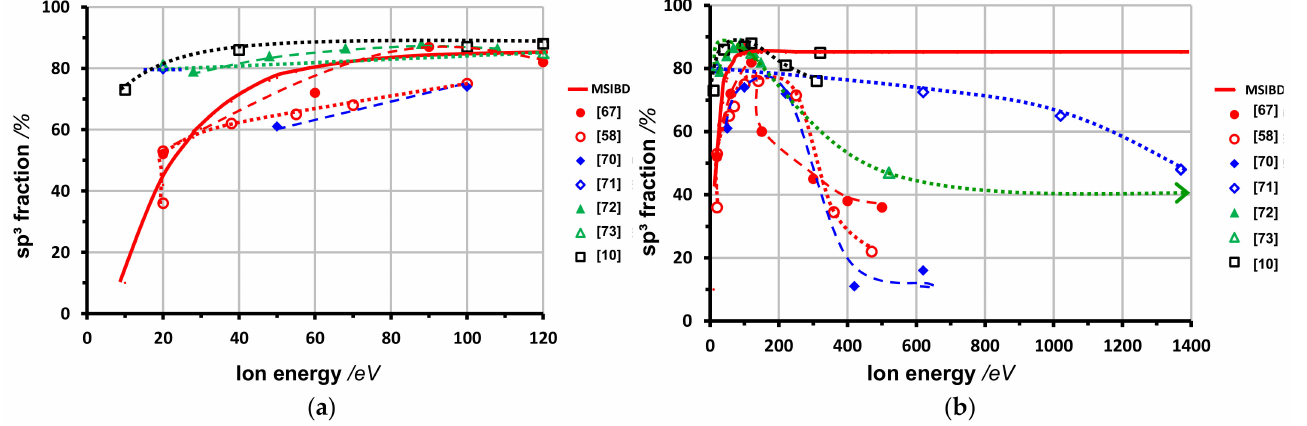
Figure 10. Dependence of the sp 3 fraction (from EELS) on the ion energy for carbon films, deposited by filtered vacuum arc. dc arc: [10,58,67,70–72], pulsed arc: [73] (300 A/5 ms, pulsed bias 2 µ s on, 6 µ s off). Empty symbols: ion energy for 0 V bias estimated by 20 eV. ( a ) Medium energy range 20–120 eV. Included Equation (12) for MSIBD (red line). ( b ) Extended energy range. Included is the curve for MSIBD ([43], red